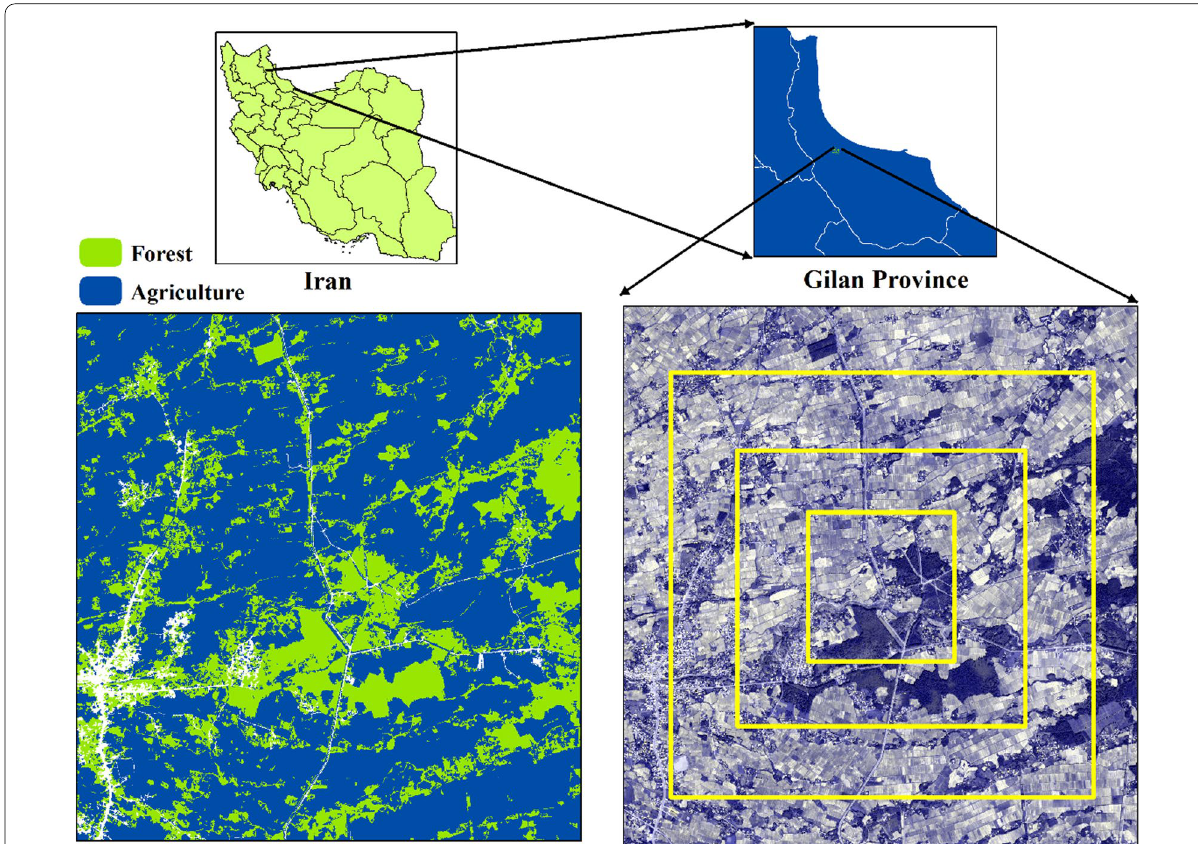
Fig. 1 Location of the study area in Iran and Gilan province. The image on the right shows an aerial photo of the study area, and four subsets for creating new patches have been drawn by yellow lines at four different spatial scales on the left. The image on the left shows the land cover map including forest and agricultural ecosystems that were obtained from the aerial